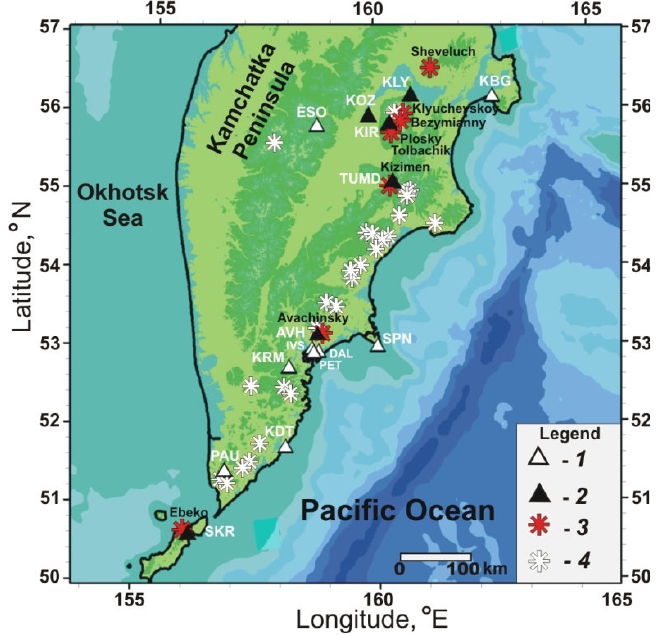
Figure 2. Location map of seismic stations and active volcanoes: 1—non-volcanic station, 2—volcanic station, 3—active volcano near which a seismic station is located, 4—active volcano at rest or near which there is no seismic station, 2011–2021.